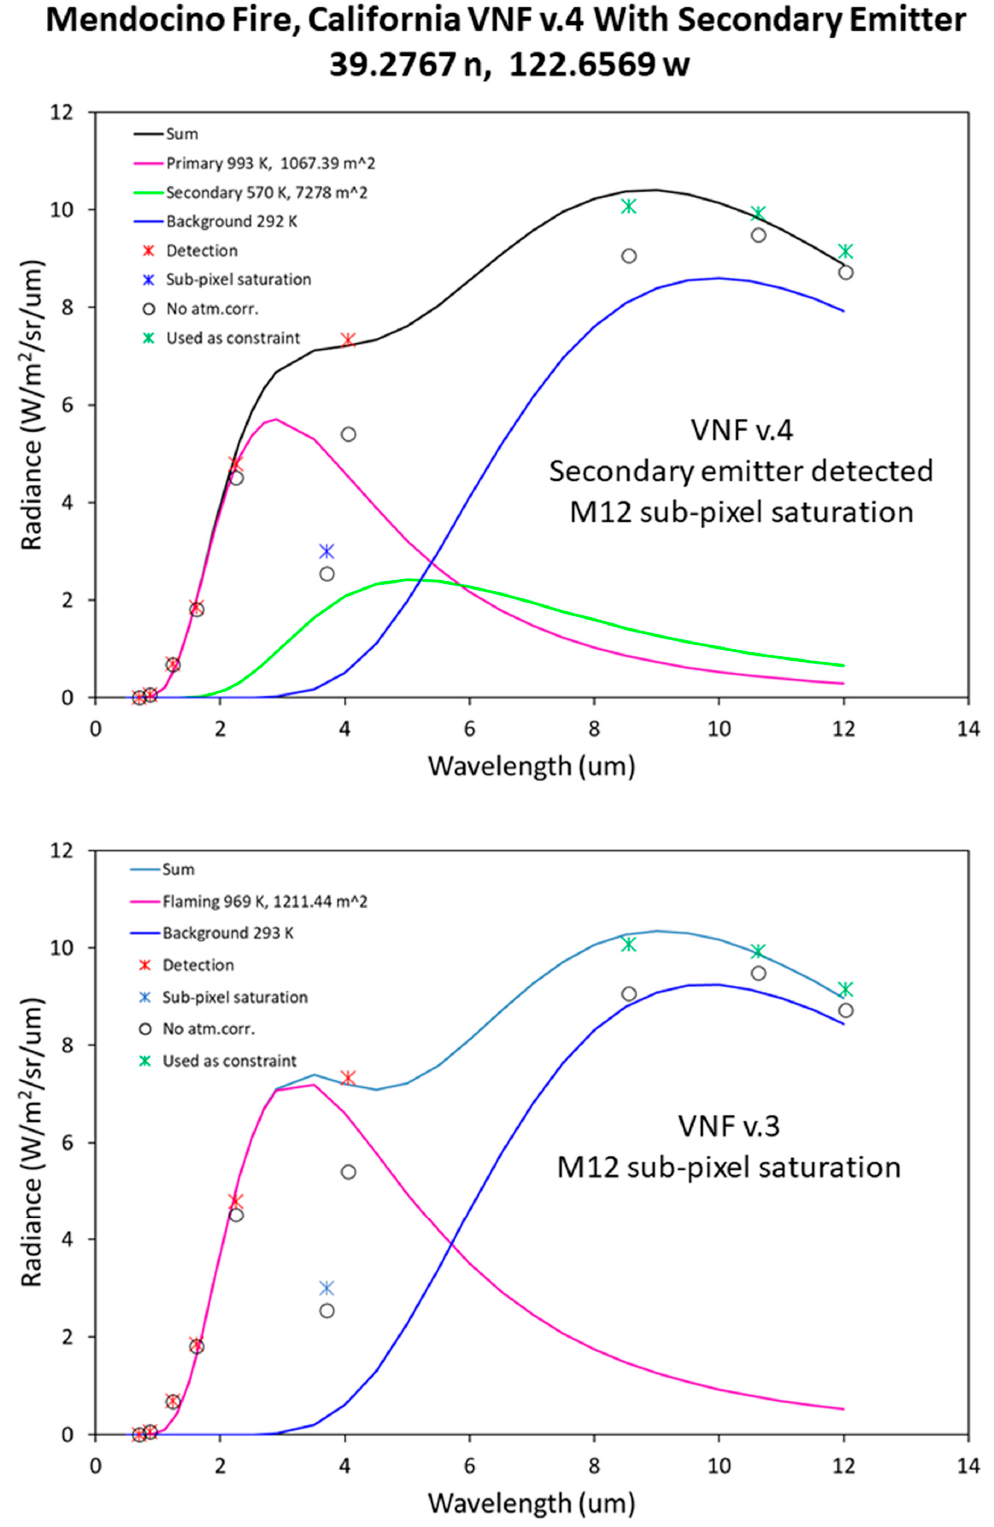
Figure 11. Spectral diagrams of a Type 4 pixel from the Mendocino Fire where a secondary emitter has been detected. Note that M12 has subpixel saturation and has been excluded from Planck curve